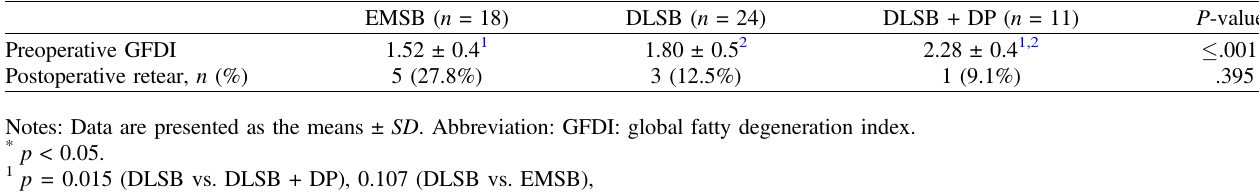
Figure 3. Clinical outcome assessment: Constant Scores. (A) Signi fi cant improvements were noted in the postoperative Constant scores as between the EMSB and DLSB groups ( p = 0.018), and between the EMSB and DLSB + DP groups ( p = 0.045). (B) Postoperative pain Constant score: a signi fi cant difference was noted in the postoperative pain between the EMSB and DLSB + DP groups ( p = 0.012). (C) Postoperative ADL. (D) Strength of the constant scores. No signi fi cant differences were noted in the postoperative ADL and strength of the Constant scores among the three groups. Table 3. Radiological fi ndings on